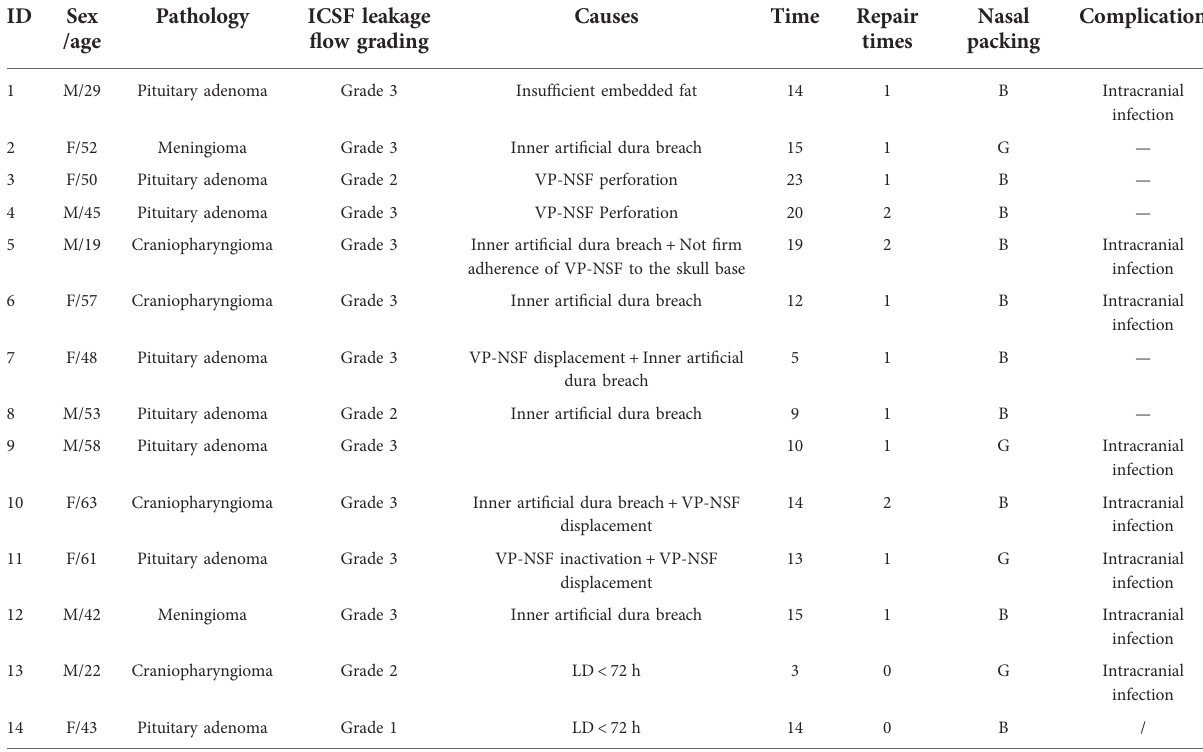
TABLE 2 Causes of CSF after endoscopic endonasal